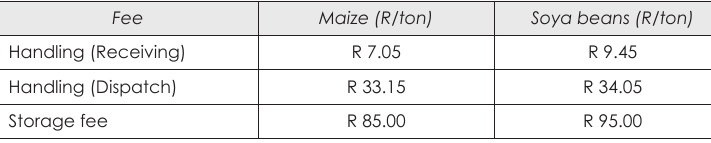
Table 2: Current long-term storage rates for storage use Fee Maize (R/ton) Soya beans (R/ton) Handling (Receiving) R 7.05 R 9.45 Handling (Dispatch) R 33.15 R 34.05 Storage fee R 85.00 R